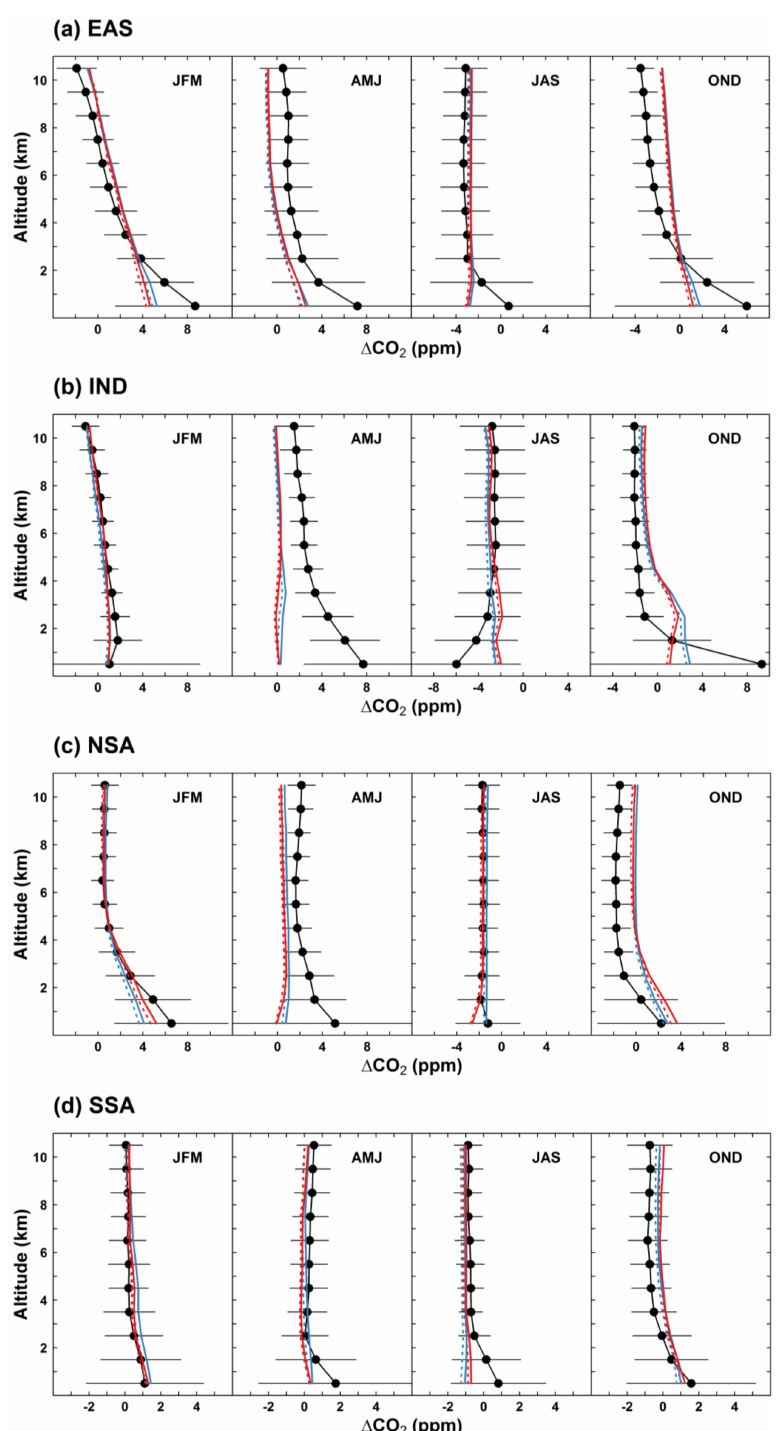
Figure 6. Seasonal mean observed and simulated CO 2 vertical profiles over (a) East Asia (EAS), (b) the Indian subcontinent (IND), (c) north- ern Southeast Asia (NSA) and (d) southern Southeast Asia (SSA). The observed vertical profiles are based on CO 2 continuous measurements onboard the commercial flights from the CONTRAIL project during the period 2006–2011. For each 1km altitude bin and each subregion, the observed and simulated time series are detrended (denoted as (cid:49) CO 2 ) and seasonally averaged during January–March (JFM),